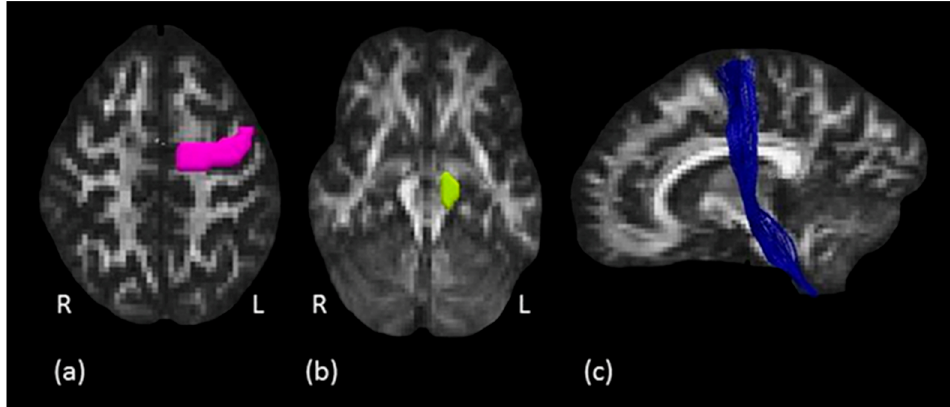
Figure 3. Corticospinal tract tractography dissection. ( a ) The pink ROI is defined around the left precentral gyrus on axial plane and ( b ) the green ROI defined around the left cerebral peduncle. ( c ) In blue, example of the left corticospinal tract in a representative subject, sagittal